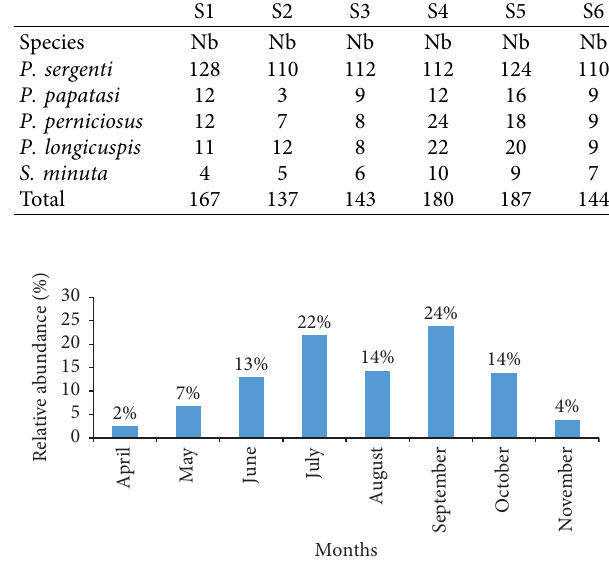
Figure 2: Temporal evolution of the relative abundance of sandfies.